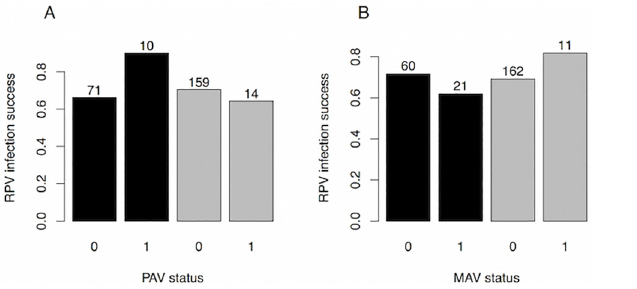
Fig 3. RPV inoculation success versus plant species and PAV (A) and MAV (B) infection status. Black bars represent Bromus hordeaceus plants, and gray bars represent Nassella pulchra plants. Other plot features are the same as in Fig 1.